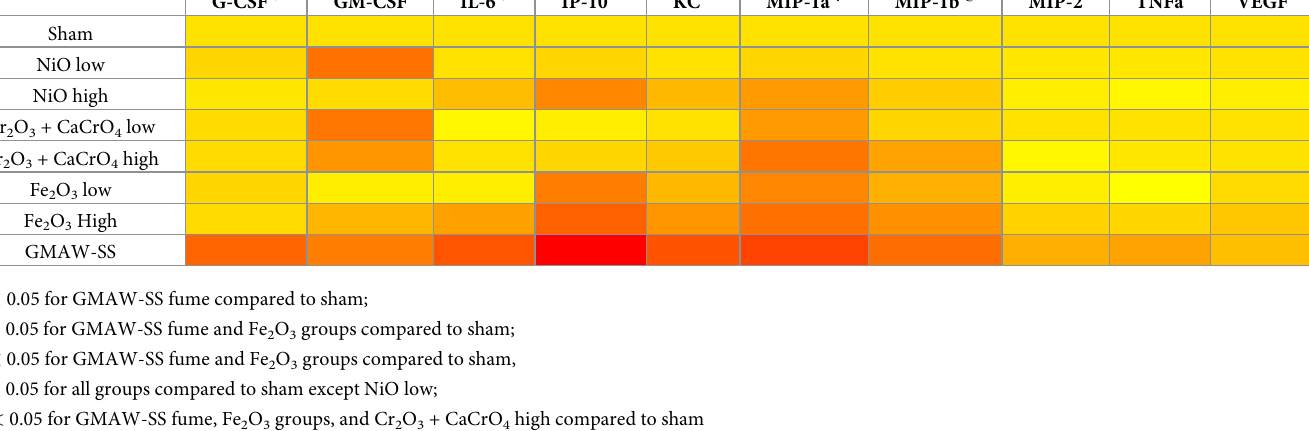
O 2 3 O + CaCrO 2 3 4 O + CaCrO high- 2 3 4